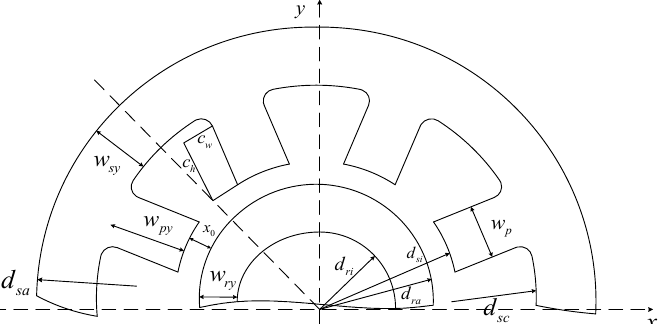
Figure 9. The 8 ‐ pole RMB geometry. Figure 9. The 8-pole RMB